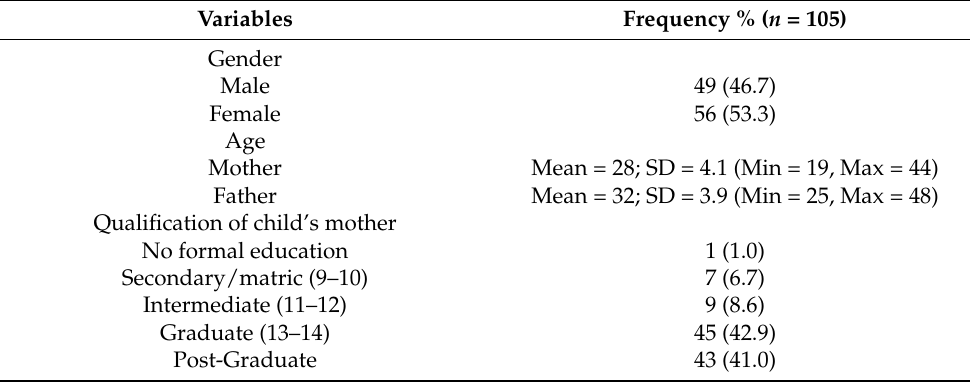
Table 2. Socio demographic and mobile phone usability characteristics of the